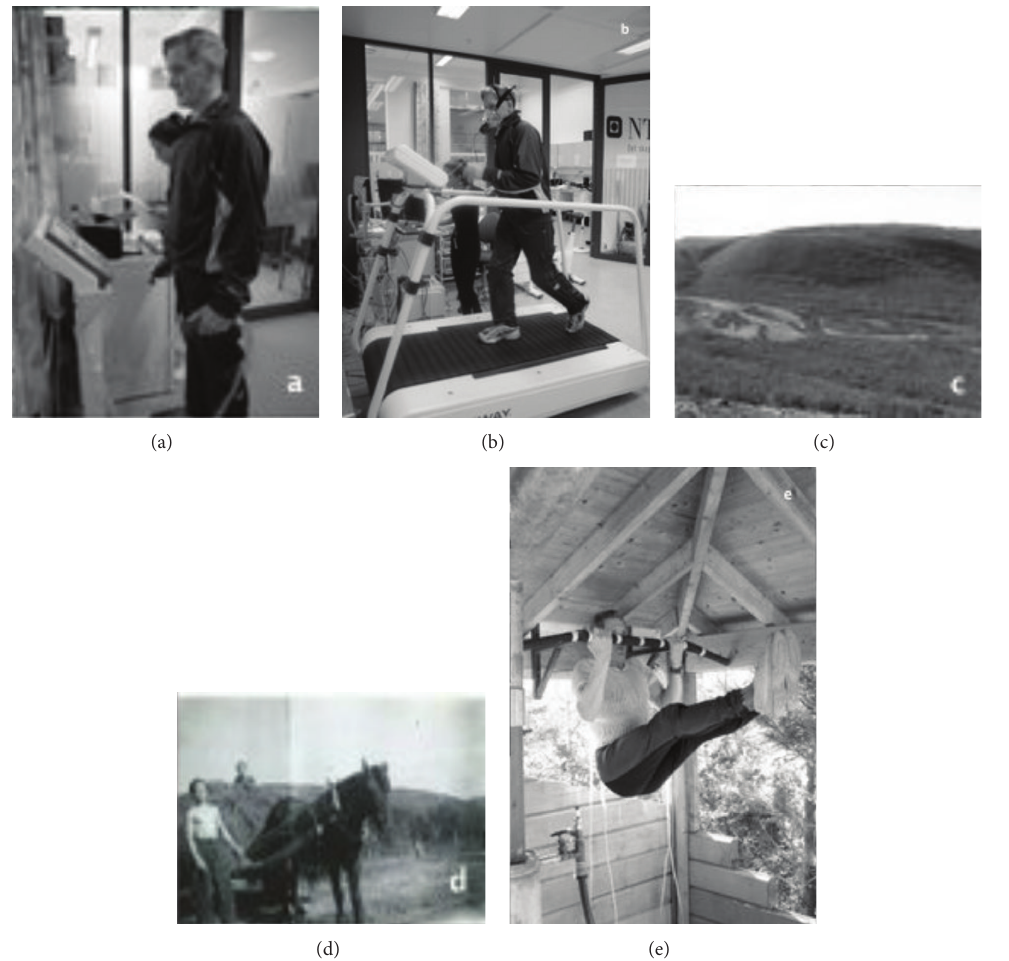
Figure 1: (a) The man measuring body composition. (b) The man running the VO 2 max test. (c) His childhood farm in Northern Norway. (d) The man doing farm work as a 13-year-old. (e) The man engaged in strength-exercise training in his home